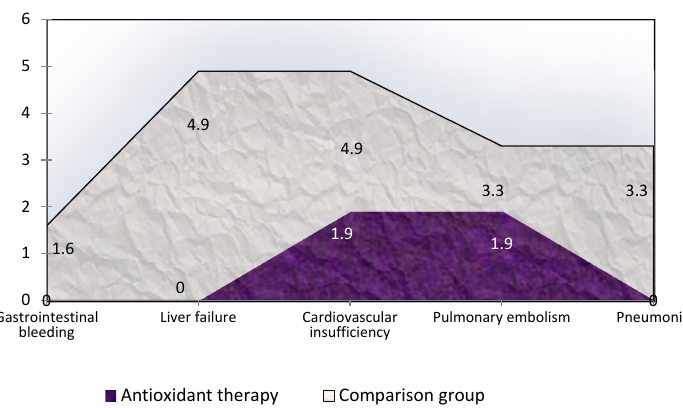
Figure 12. Frequency (%) and causes of hospital mortality in patients with obstructive jaundice who received and did not receive antioxidant therapy. A significant decrease in hospital mortality was determined in general. This was at- tributed to the mortality of patients with inoperable neoplastic jaundice in the comparison group, while in the AOT group all patients with neoplastic jaundice survived and were discharged from the hospital. There were no statistically significant differences in hospital mortality among patients with non-neoplastic-induced OJ between the groups, despite the upward trend in the survival rate from 86% in the comparison group to 94.6% in the AOT-treated group (Table 6). Table 6. Hospital outcome of patients in the study groups. I Comparison II AOT Group ( n Outcome Group ( n =61) = 52)